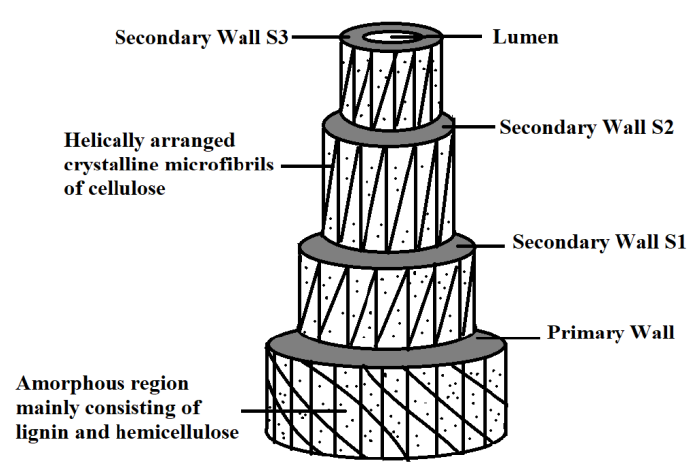
Figure 7. The structure of a single fibre cell. Table 1. Chemical constituent content in different natural fiber